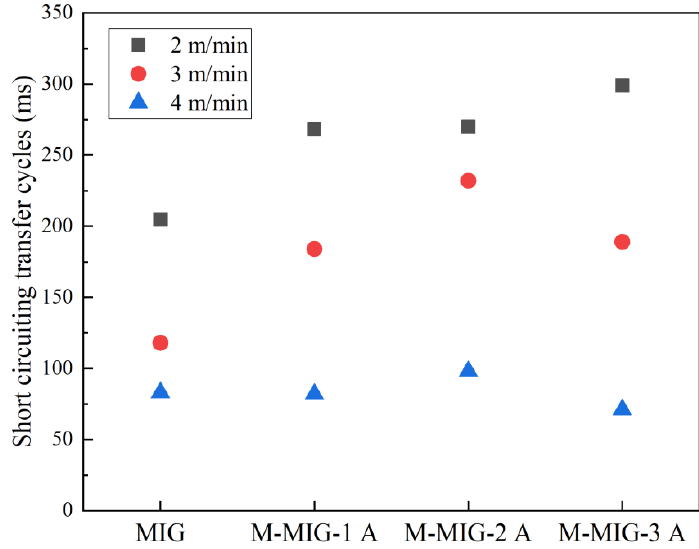
Figure 5. Short-circuiting transfer cycles with different wire feeding